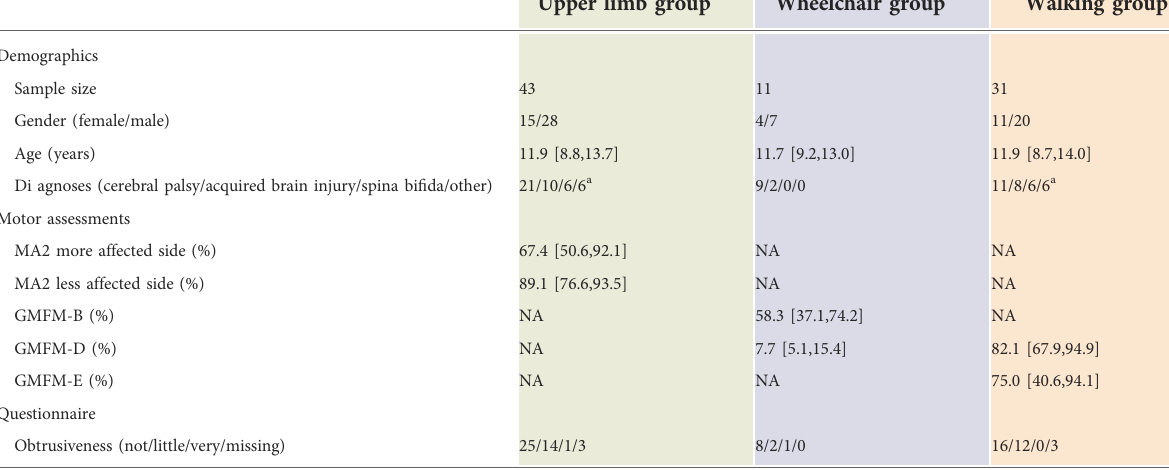
TABLE 2 Participants ’ demographics, motor abilities and obtrusiveness